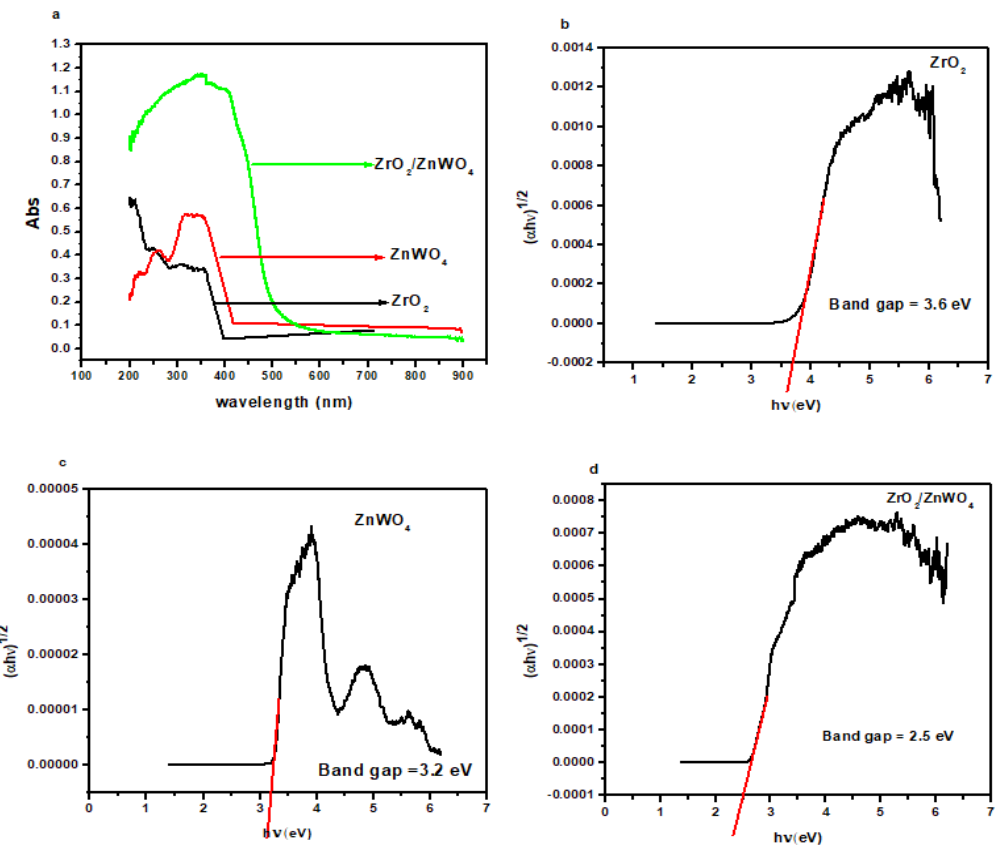
Fig. 1. (a). UV – vis -DRS spectra of ZrO